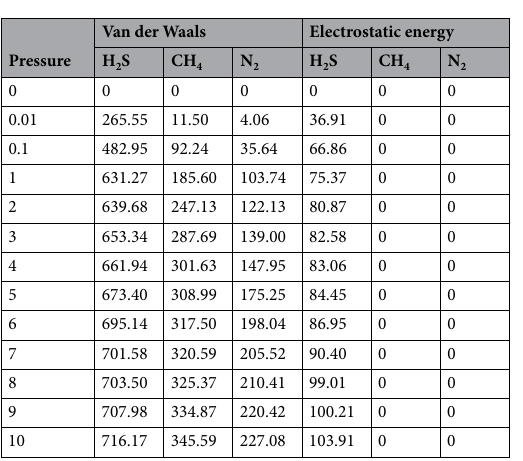
Table 3. Van der Waals and electrostatic energy of adsorption of each gas at different